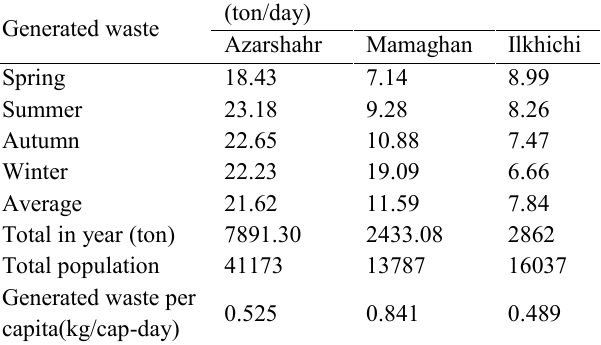
Table 1. The seasonal and annul amount of generated wastes in the studied